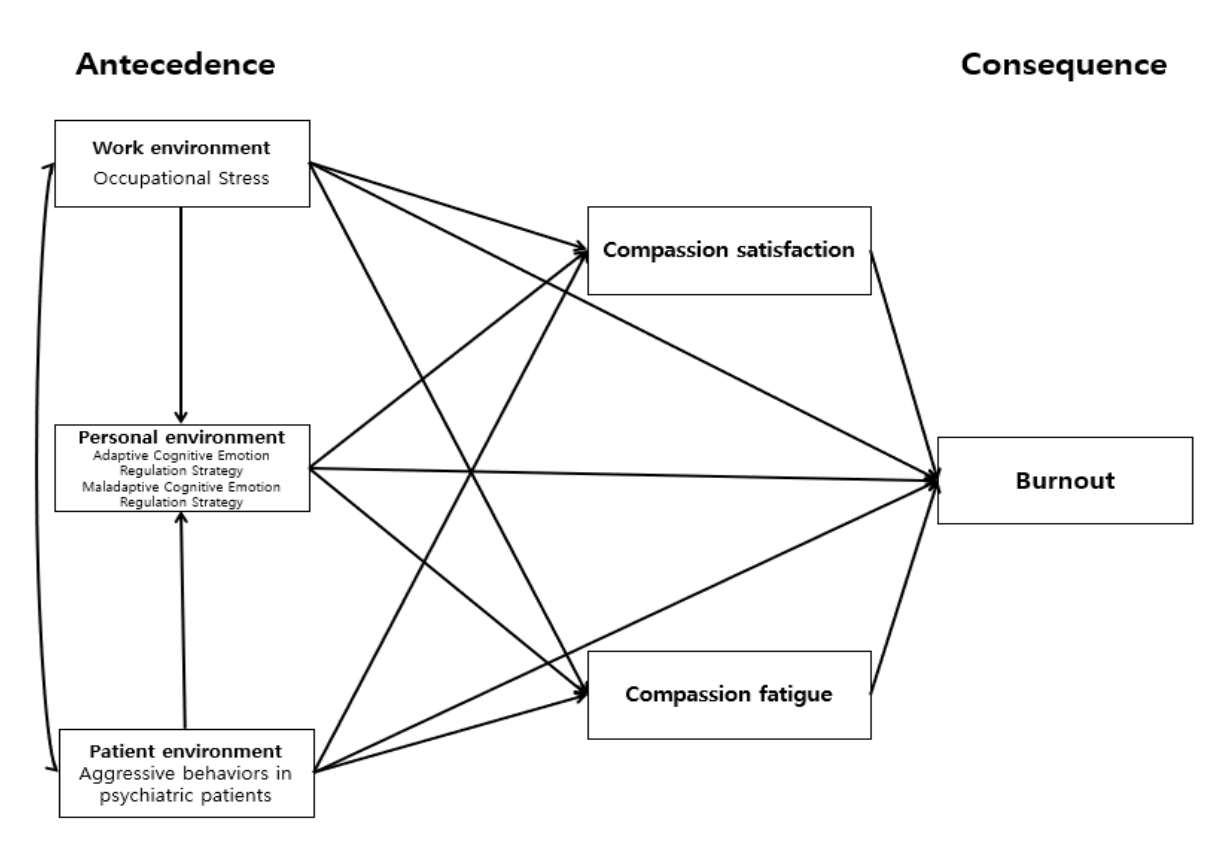
Figure 1. Conceptual framework.